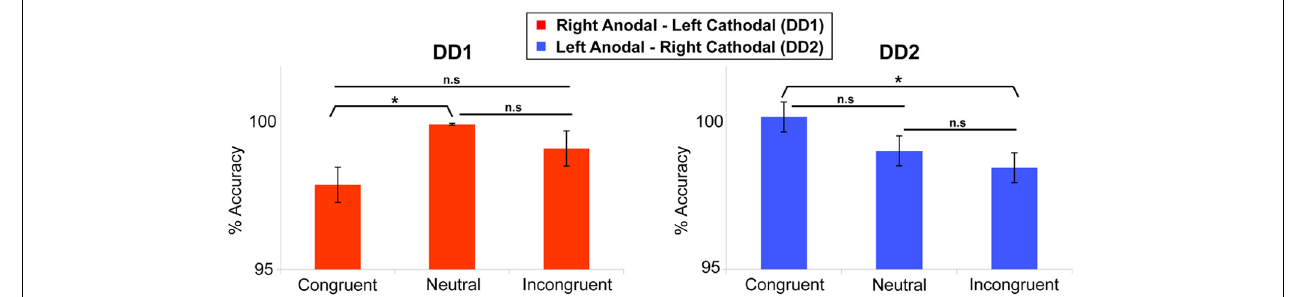
FIGURE 5 | Numerical Stroop task. Congruency effect (measured in terms of accuracy) for the two DD individuals. DD1 did not exhibit the canonical Congruency effect (Congruent > Neutral > Incongruent), while DD2 showed a clear Congruency pattern in the predicted direction. For DD1: Neutral >